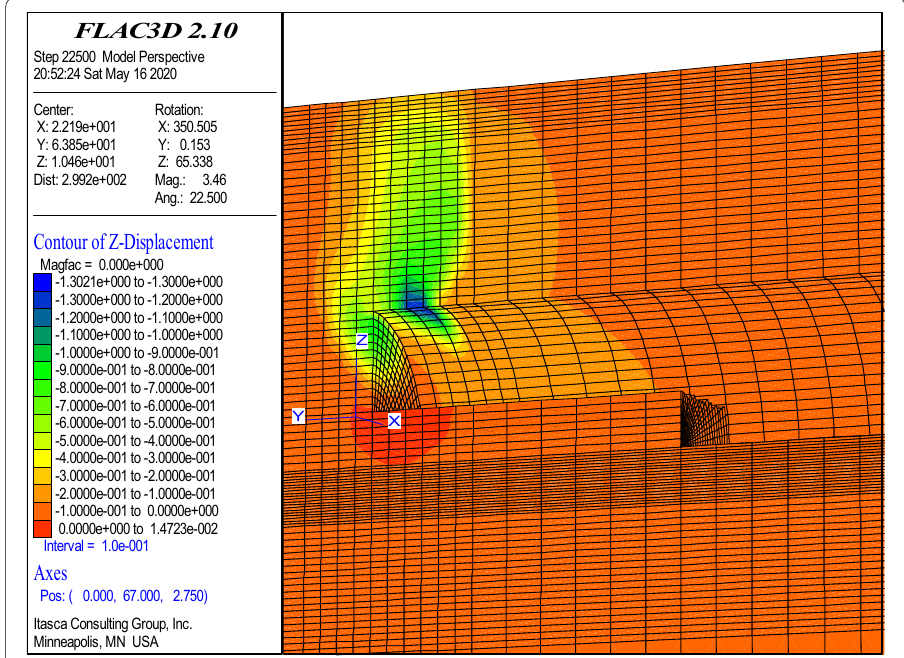
Fig. 17 Displacement in Z